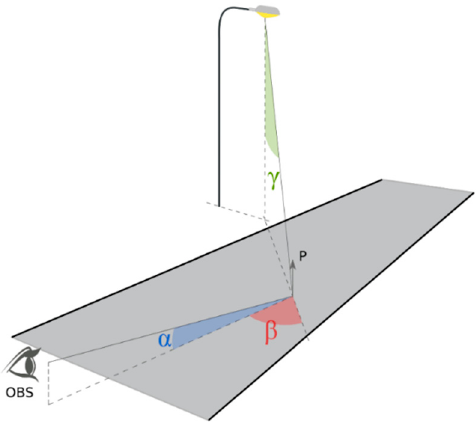
Figure 3. Angular relationships used for the luminance calculation.